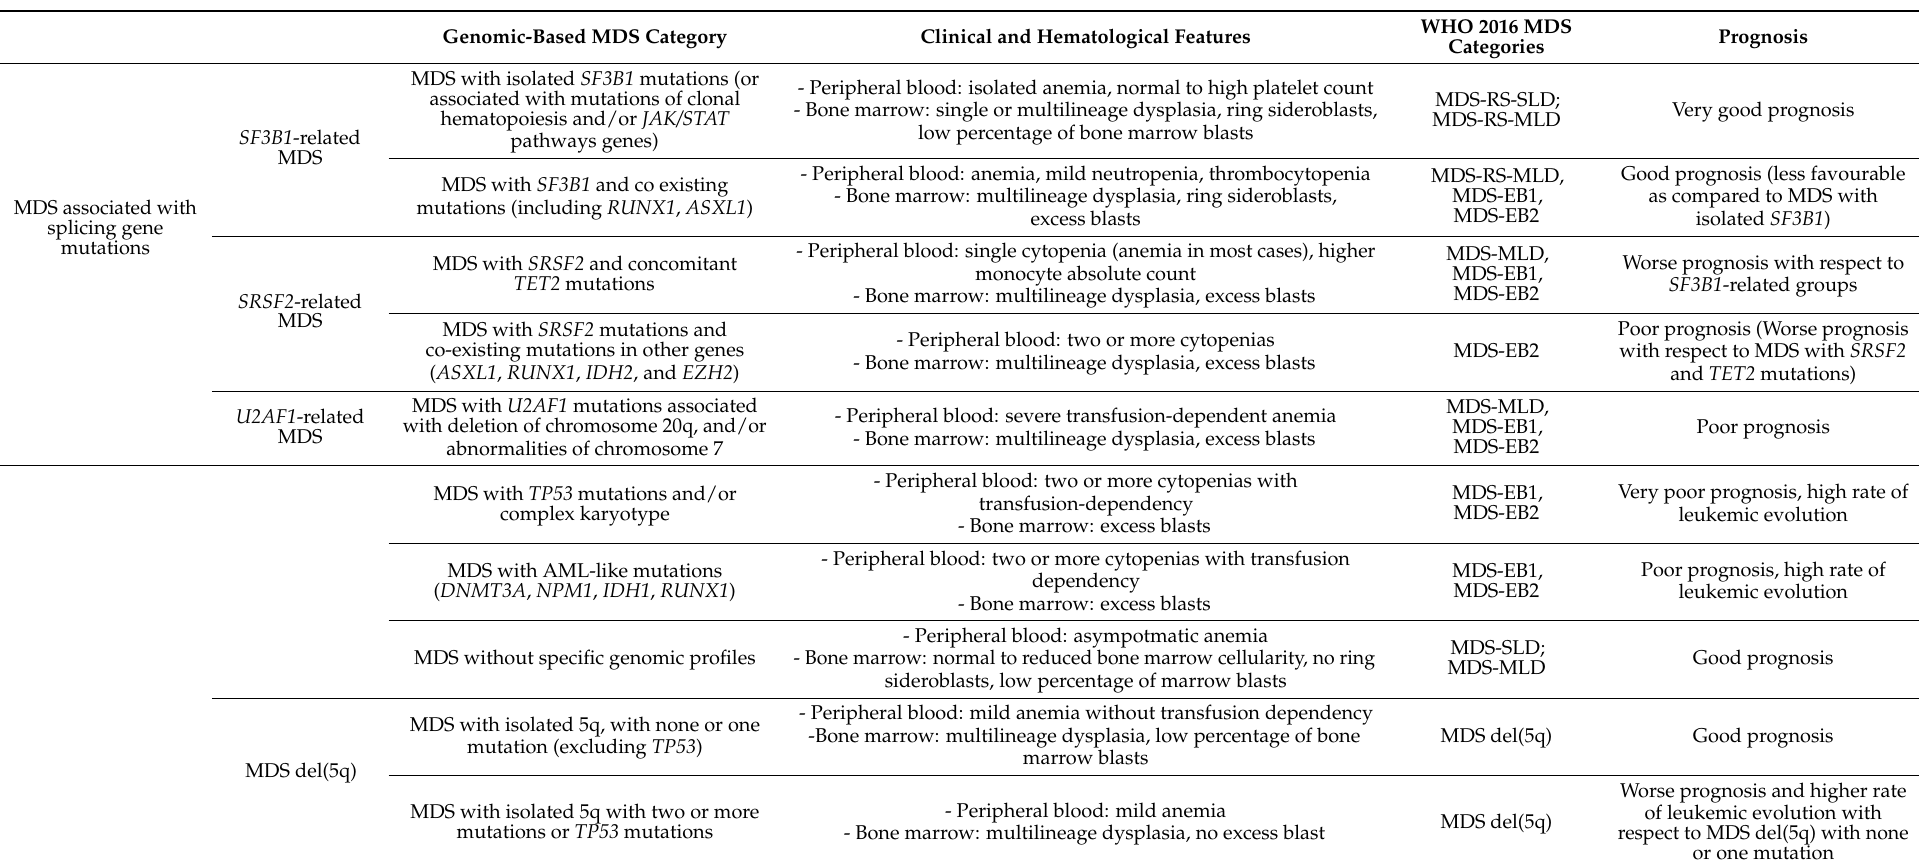
Table 1. Molecular classification of myelodysplastic syndromes. MDS del(5q), MDS with isolated deletion of long arm of chromosome 5; MDS-SLD, MDS with single lineage dysplasia; MDS-MLD, MDS with multilineage dysplasia; MDS-RS-SLD, MDS with ring sideroblasts and single lineage dysplasia; MDS-RS-MLD, MDS with ring sideroblasts and